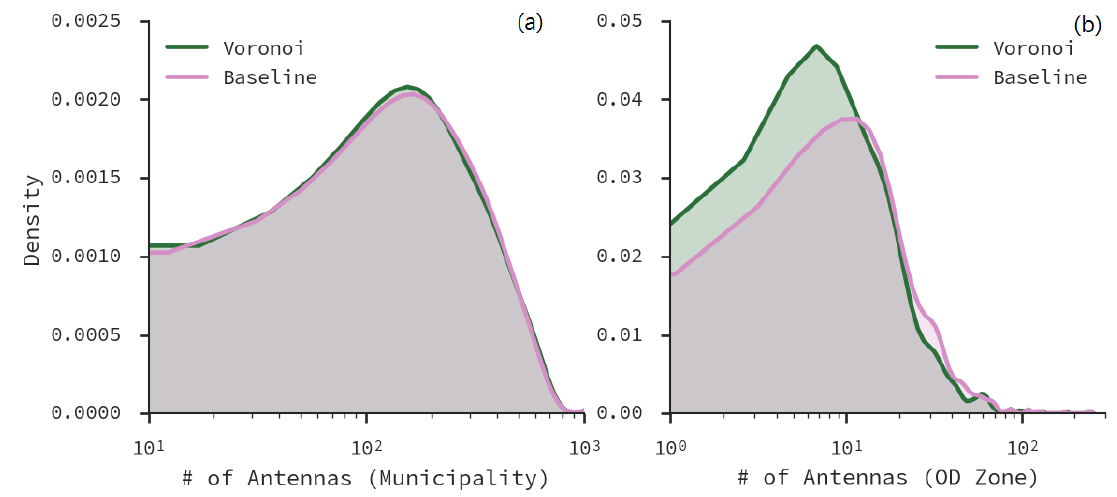
Figure 8. ( a ) Distribution of antenna positions per municipality; ( b ) Distribution of antenna positions per OD zone.